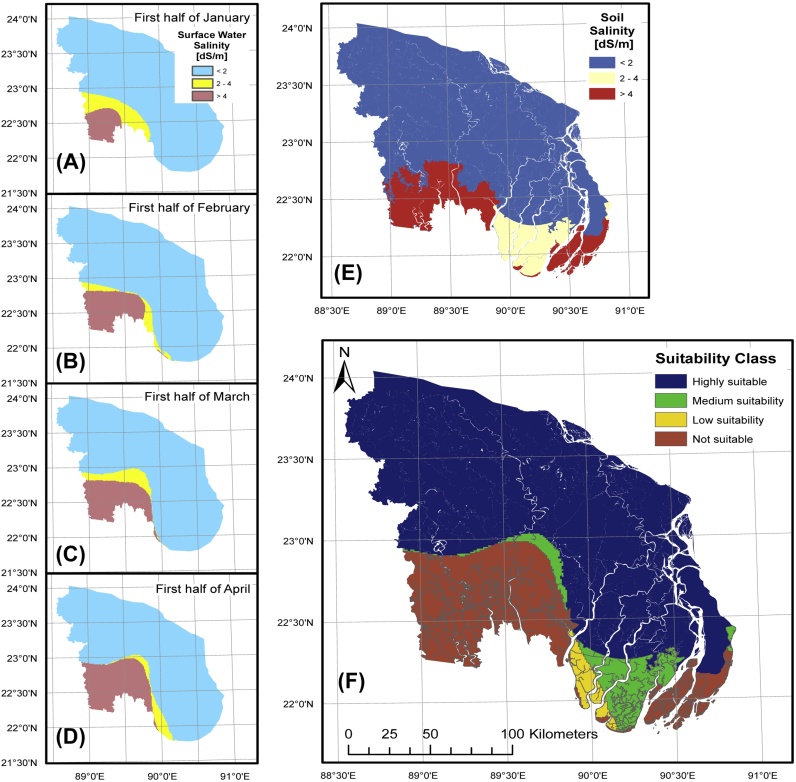
Fresh and brackish water movement in the study zone delta in (A) January, (B) February, (C) March, (D) April. Maximum soil salinity (E) is presented for the height of the dry season before rains start. (F) Combined map overlaying maximum soil and water salinity according to the index detailed in Table 1. For interpretation of the colour classifications used in this figure, the reader is referred to the online version of this paper.